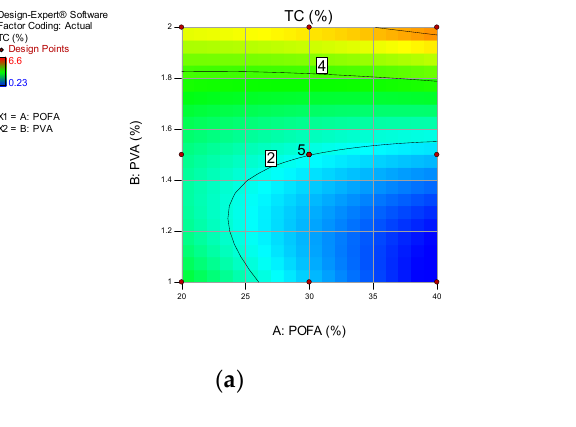
Figure 23. ( a ) 2D Contour Plot and ( b ) 3D Response Surface Diagram for Tensile Strain Capacity.